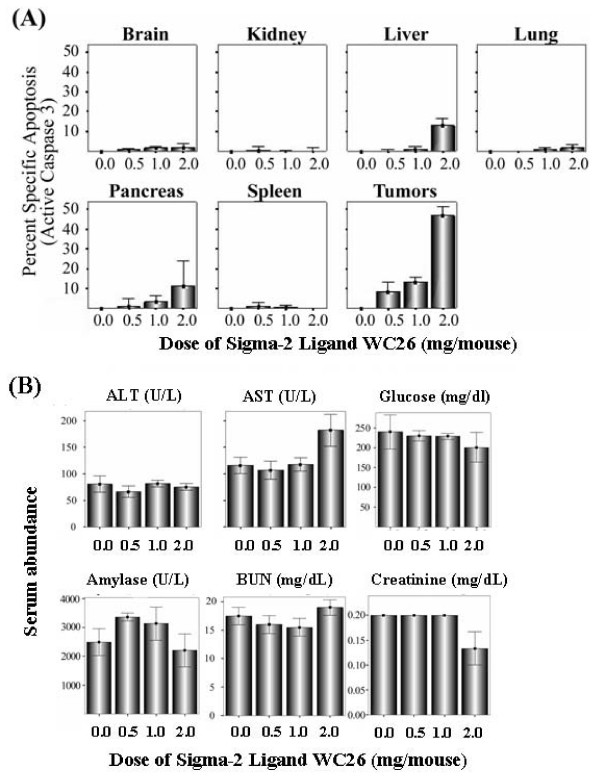
Systemic administration of Sigma-2 receptor ligand induces substantial tumor apoptosis without major toxicity. (A): Systemic administration of the sigma-2 receptor ligand WC26 induces considerable apoptosis in Panc-02 tumor allografts (up to 50% of tumor cells were active caspase-3 positive following a single 2 mg dose of WC26, p < 0.0001). Data reported as percent specific apoptosis (percent specific apoptosis = observed apoptosis – tissue specific background apoptosis). (B): The mice appeared normal and no apparent toxicity was noted in serum biochemical analysis or by immunohistochemistry (data not shown). Reference ranges for the blood chemistry panel in C57Bl/6 mice: ALT: 18–184 U/L, AST: 55–251 U/L, glucose: 174–335 mg/dL, amylase: 2595 +/- 212 U/L, BUN: 34–58 mg/dL, creatinine < 1.1 mg/dL.